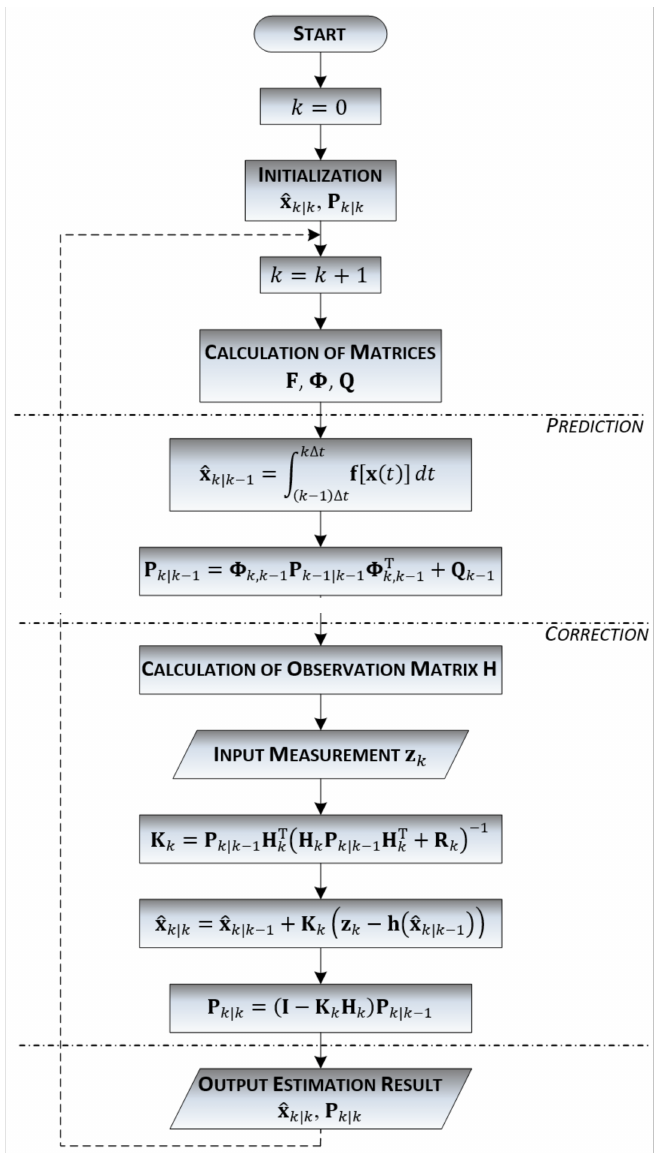
Figure 8. Flowchart of the Extended Kalman Filter used for HH-GPR antenna position